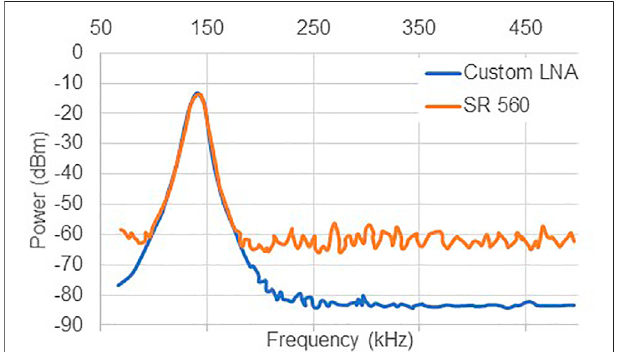
FIGURE4 | A comparison ofthe noise fl oor and signal level between the customLNAandtheSR560.ThecustomLNAshowsa20 dBimprovementin noise fl oor over the SR560. Data points were extracted and plotted from an analog spectrum